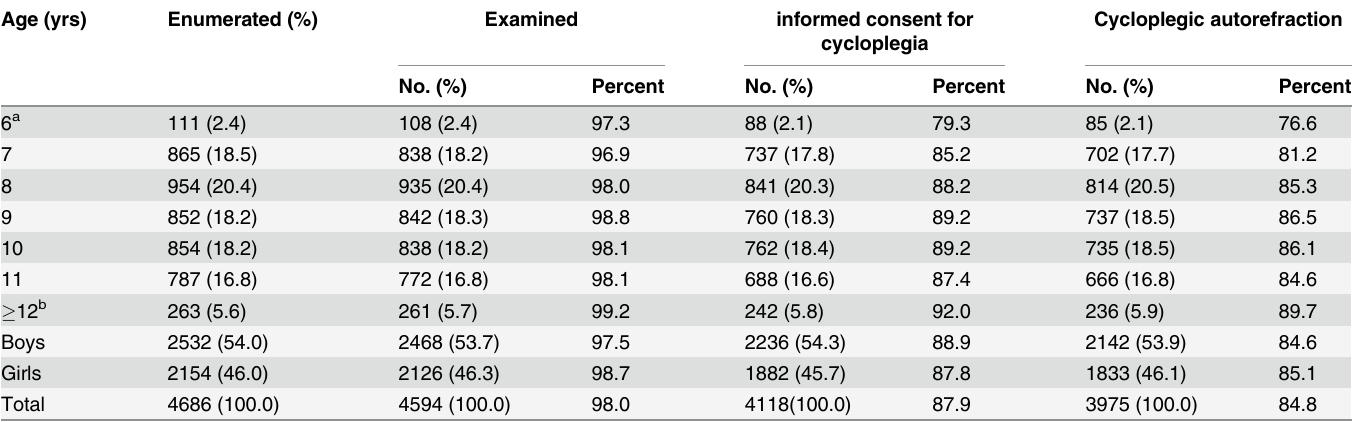
Table 1. Enumerated and examined population by age and gender. Age (yrs) Enumerated